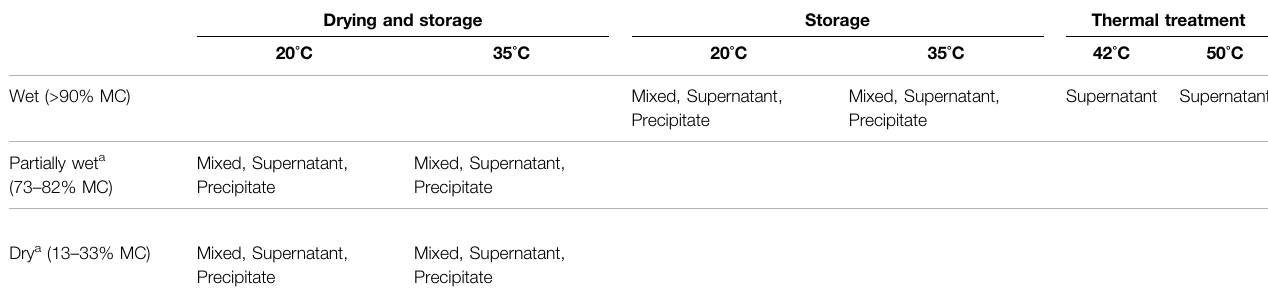
TABLE 1 | Three solution treatments (Drying and Storage, Storage and Thermal treatment) distributed across temperature and moisture content and the different fractions (described in Figure 1